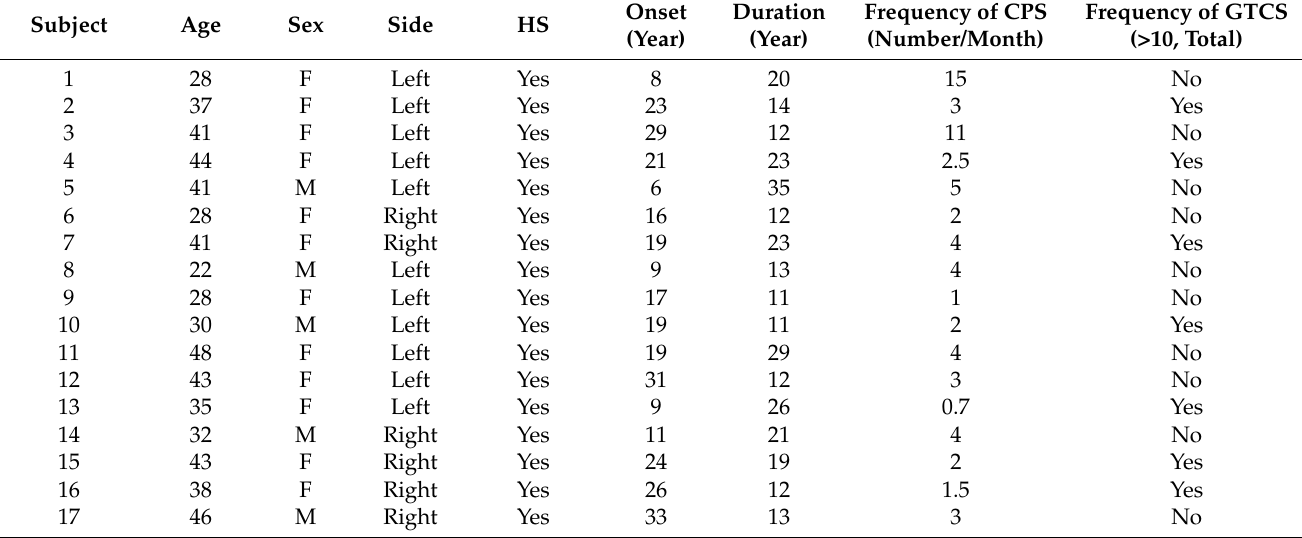
Figure 2. Statistical parametric mapping (SPM) of the fractional anisotropy (FA) changes in left temporal lobe epilepsy with hippocampal sclerosis (left TLE with HS). ( A ) Reduced FA correlated with decreased hippocampal volume: ( a ) bilateral inferior frontal areas; ( b ) right hippocampus; ( c ) left amygdala and hippocampus. ( B ) Reduced FA correlated with decreased thalamic volume: ( a ) left prefrontal area; ( b ) right cingulate gyrus; ( c ) left amygdala (corrected for family-wise error, p < 0.05). Table 1. Patient demographics and clinical information.